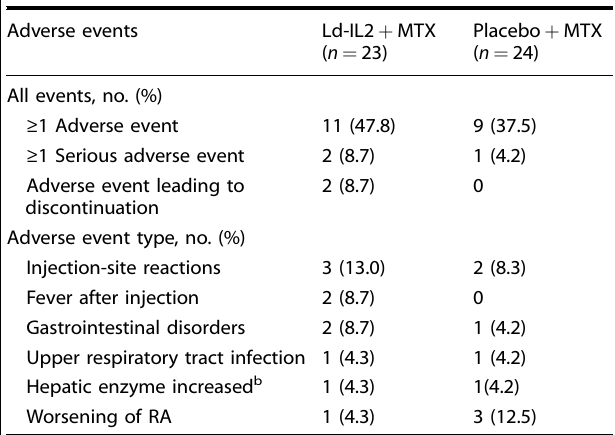
Placebo + MTX ( n = 23) ( n = 24)